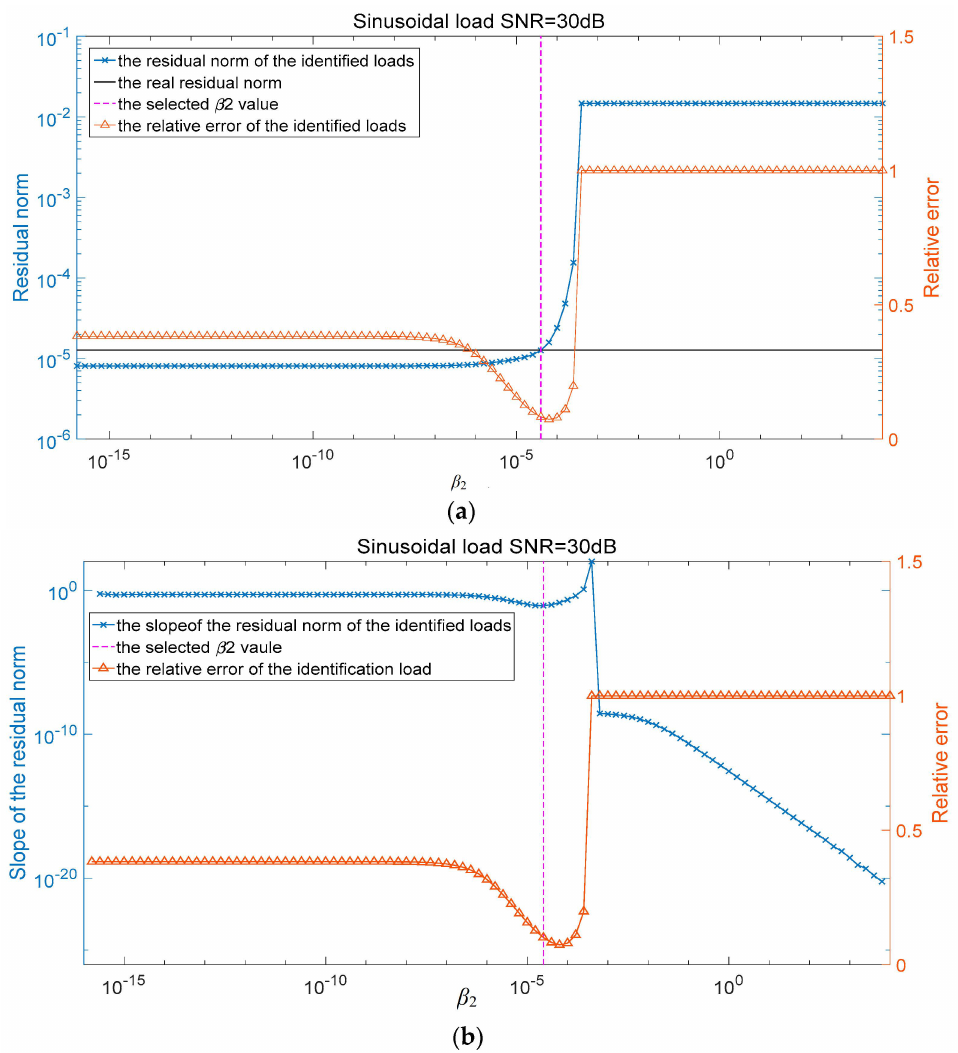
Figure 3. ( a ) β 2 selection with the response noise level known. ( b ) β 2 selection with the response noise level